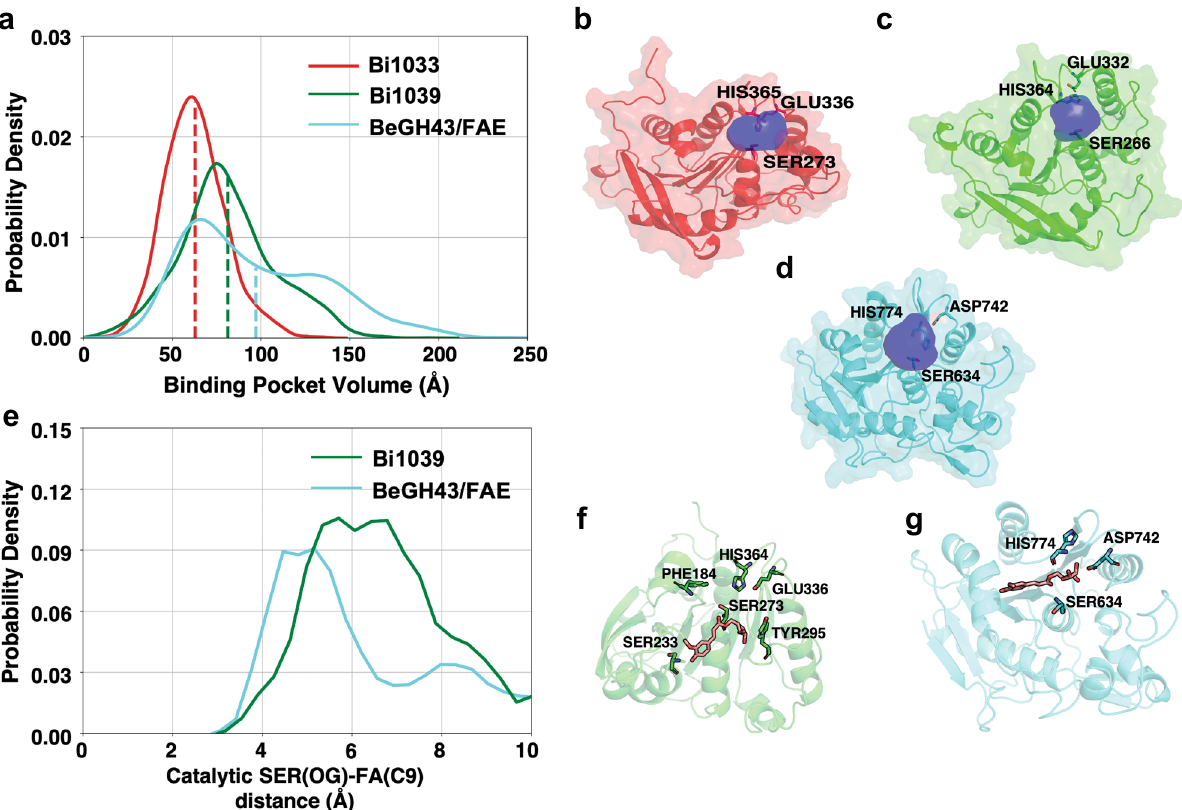
Fig. 7 Larger substrate accessible volume is correlated with selectivity differences. a Binding pocket volumes of Bi1033-CE1 (red), Bi1039-CE1 (green), and the FAE domain of BeGH43/FAE (cyan) trajectories are represented as histogram. Pocket volumes were calculated for the frames with 1 ns interval of each trajectory. Mean binding pocket volumes are represented as vertical lines. b , c , d Cartoon and surface representation of esterase domains of Bi1033- CE1, Bi1039-CE1, and BeGH43/FAE, respectively, are presented. Catalytic triad residues are shown as sticks. Representative mean pocket volumes are displayed as transparent blue surface. e Binding distance of FA(C9) & SER(OG) are represented as Markov state model (MSM) weighted 1-D histogram. f , g Cartoon representation of stable binding poses of FA substrate close to active site in Bi1039-CE1 and in the FAE domain of BeGH43/FAE,